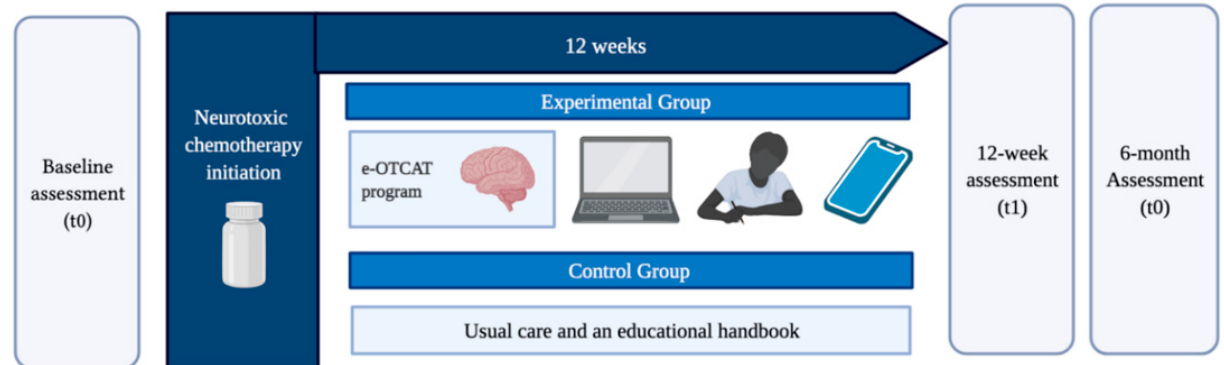
Figure 2. Time-points of the study. Created by Biorender.com.